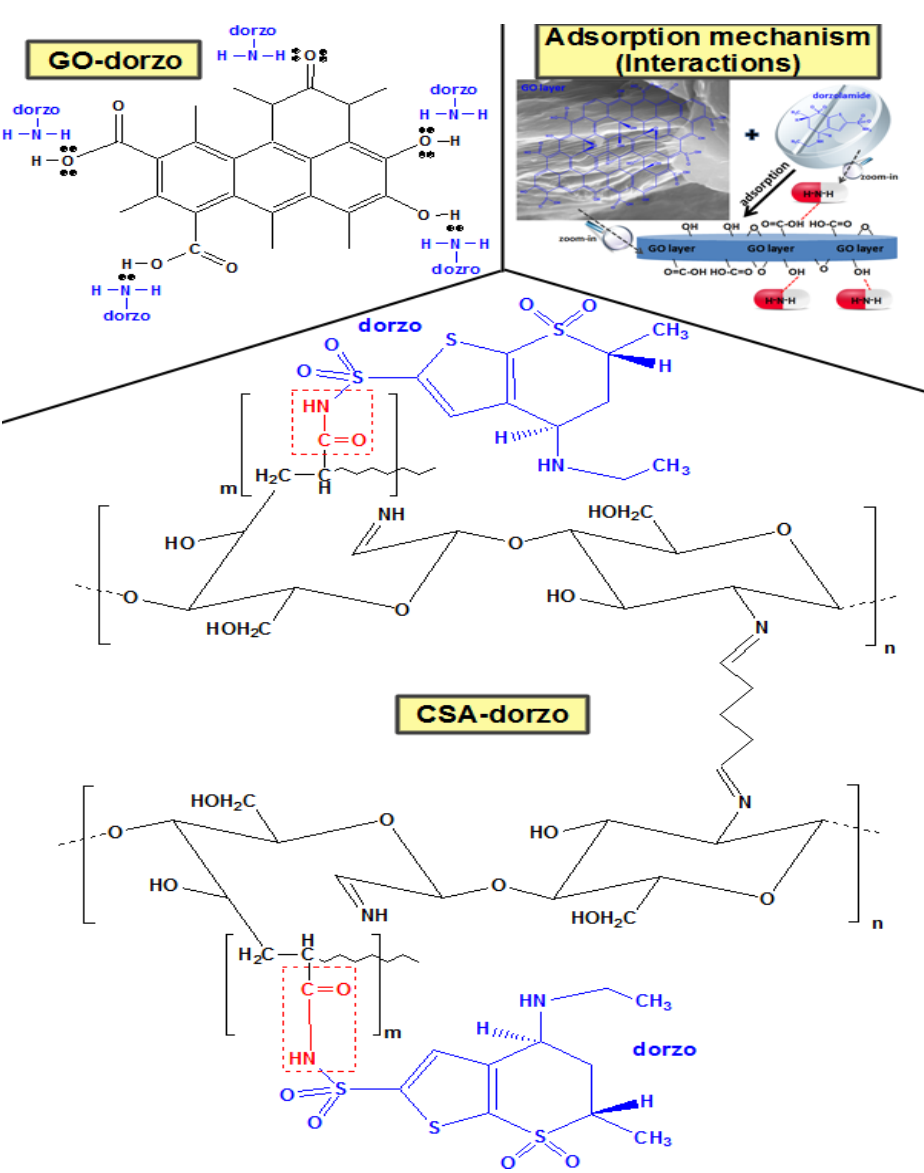
Figure 16. Adsorption mechanism and proposed interactions between dorzolamide and GO [31].